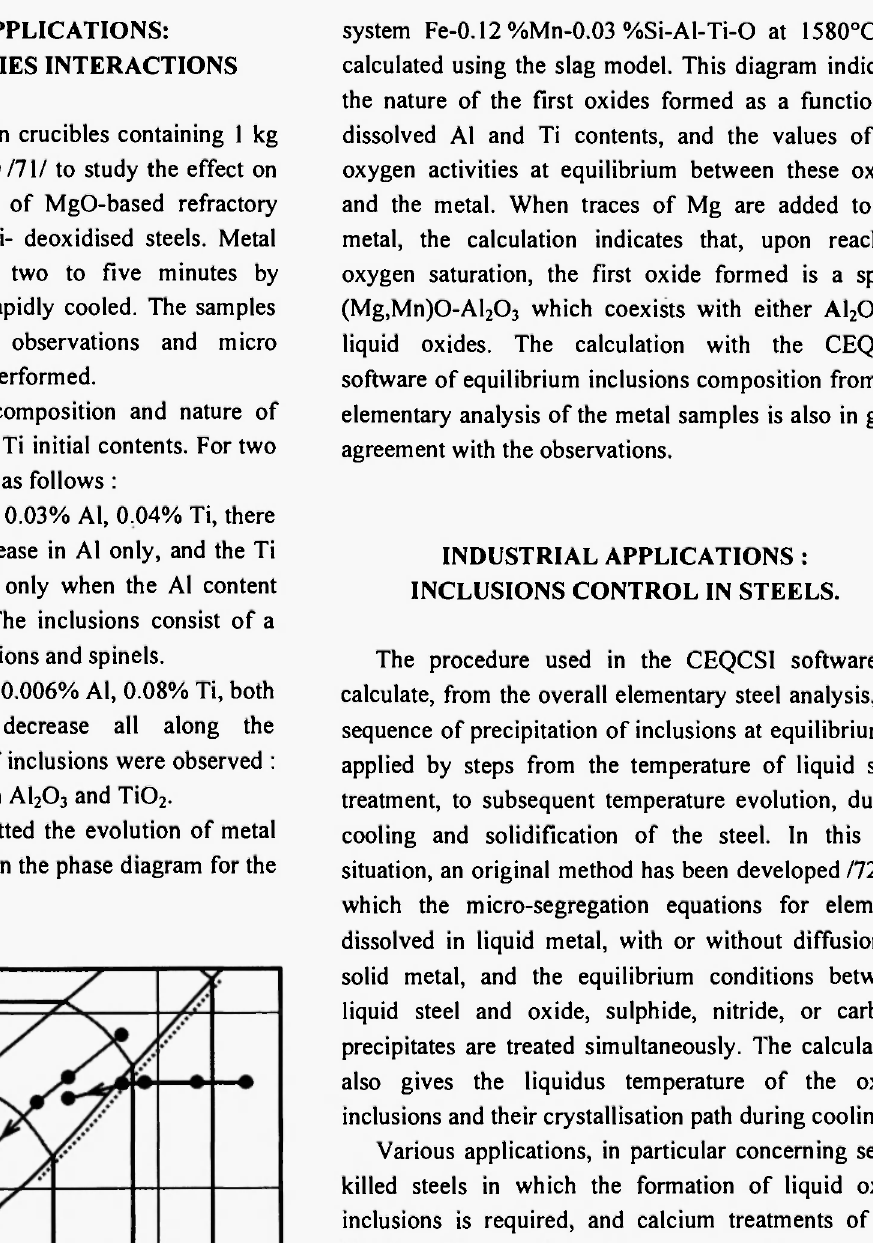
Fig. 3: Evolution of metal composition during two oxidation treatments in the laboratory, plotted on the computed equilibrium diagram for the system Fe-0.12%Mn-0.03%Si-Al-Ti-0 at